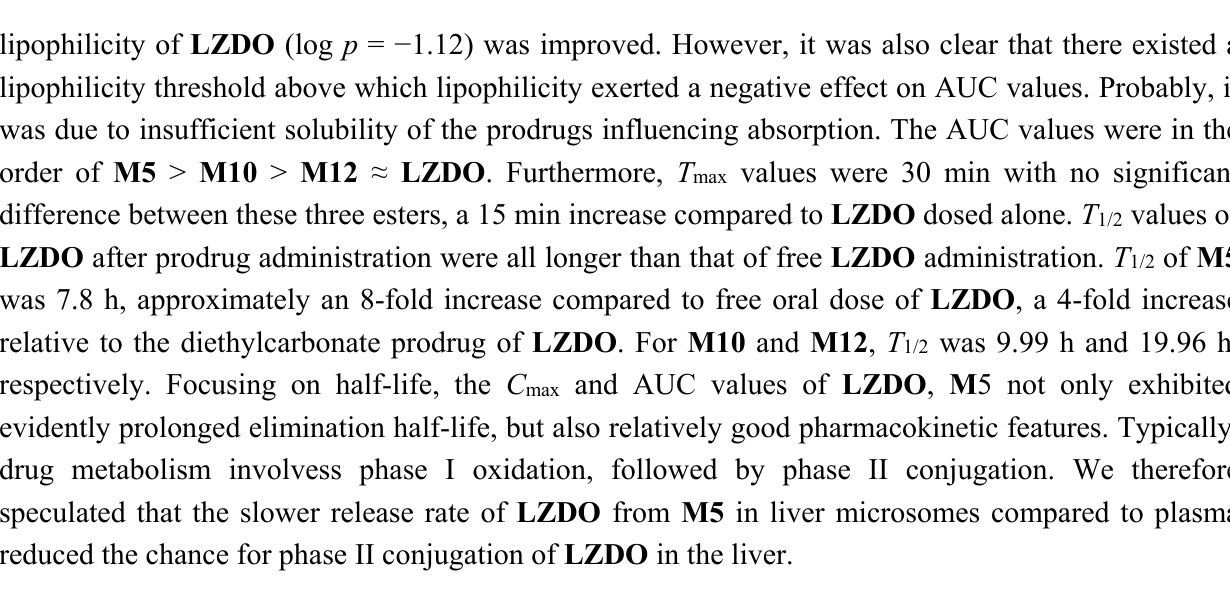
Table 4. Pharmacokinetic parameters of LZDO after oral administration of free LZDO , M5 , M10 and M12 (mean ± SD; n = 6).